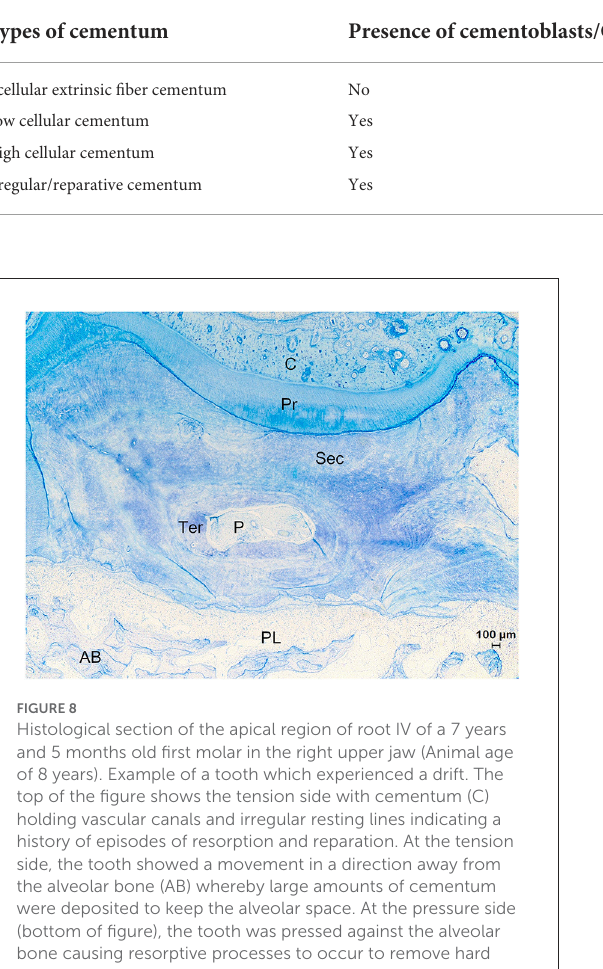
TABLE 3 Differentiation of the different types of cementum observed in alpaca cheek teeth based on the presence, concentration, and distribution of cementoblasts and/or cementoblast lacunae (CL).